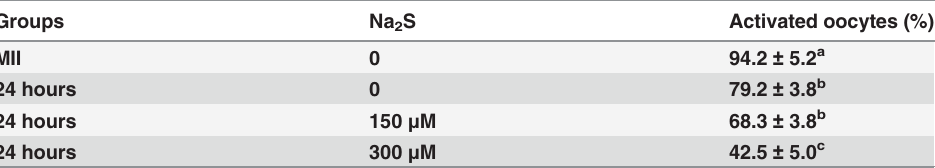
At Oocytes were cultivated 48 hours to the metaphase II and then divided into 4 groups (see table). Control group (MII) was parthenogenetically activated immediately (without any exposure to prolonged